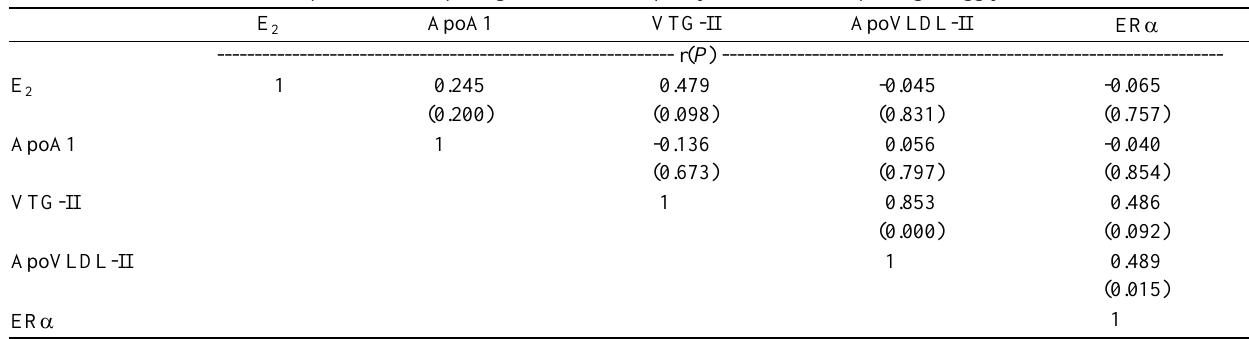
Pearson’s correlation coefficients (r) are shown with p values in parentheses.